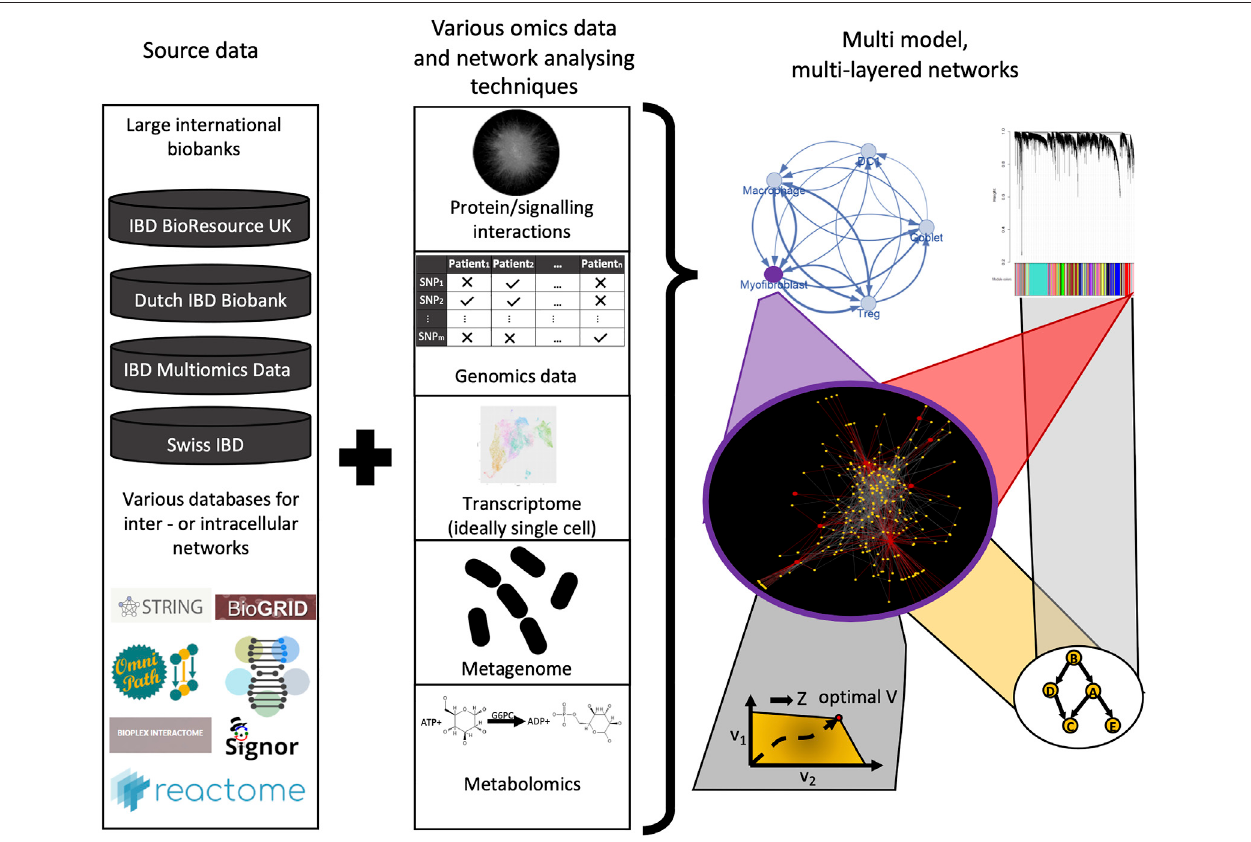
FIGURE 6 | Future perspectives of using network biology and network based modeling in IBD research. From the large amount of omics datasets (genomics, transcriptomics, metabolomics, metagenomics), various interaction networks can be used to develop sophisticated network models, ideally in a multi-layered fashion. Adding granularity with patient metadata from large databases can help to validate these models and will result in better understanding of IBD pathogenesis, novel/ personalised therapeutic strategies, and clinical decision-driving signatures.